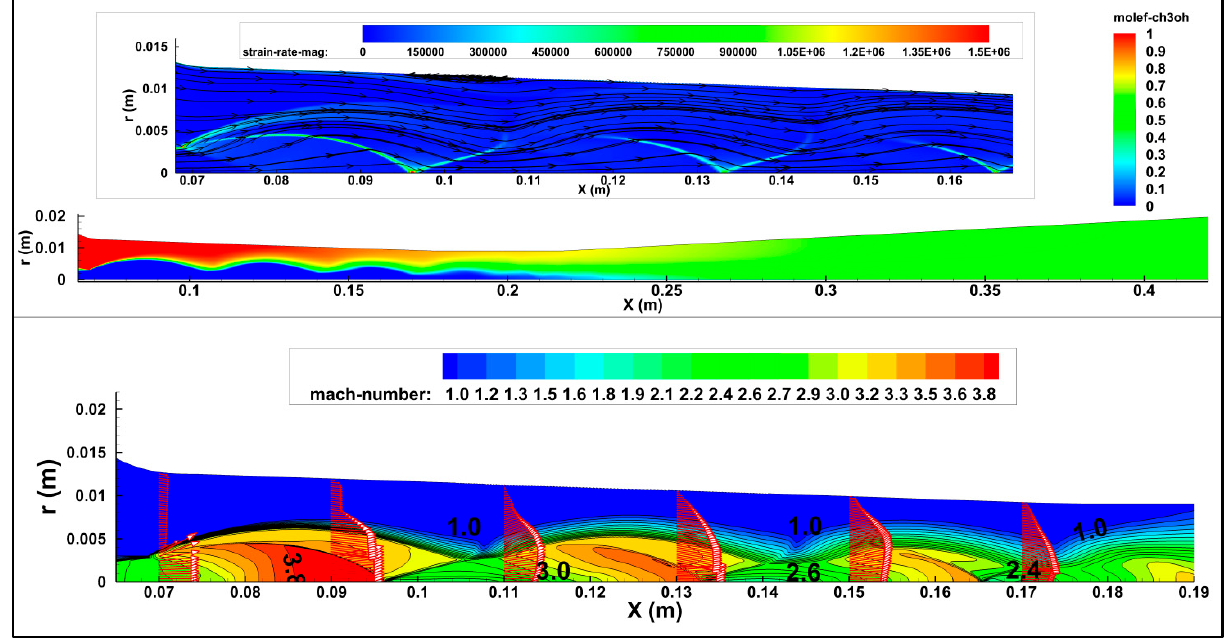
Figure 5. Flow dynamics inside the ejector at a compression ratio of 2.63 for the CF2I2-CH3OH fluid